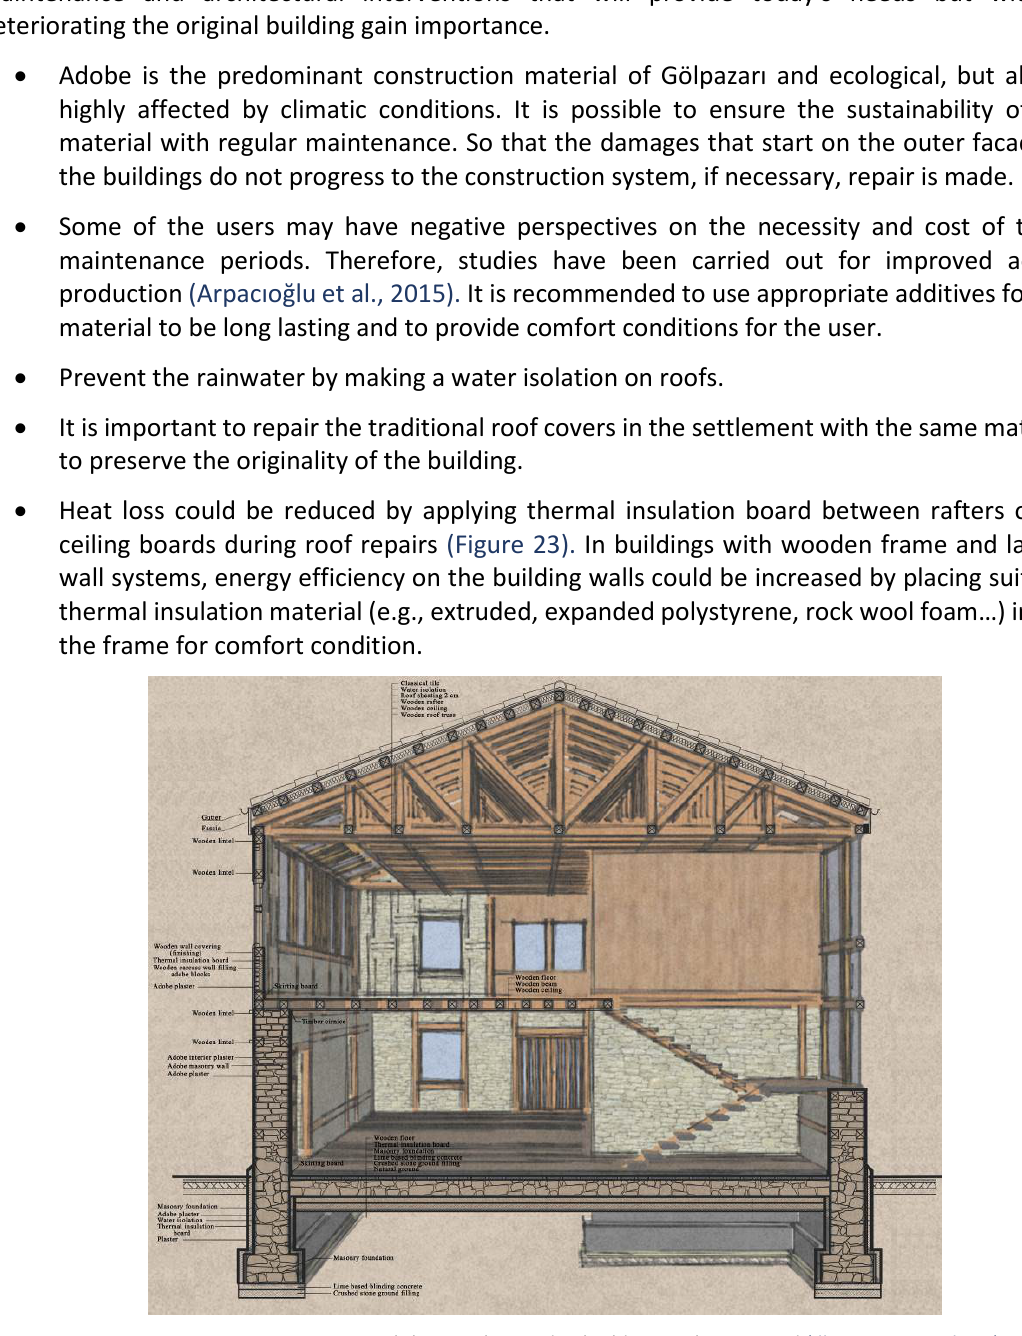
Figure 23 System section proposal that can be used in buildings to be restored (illustration: